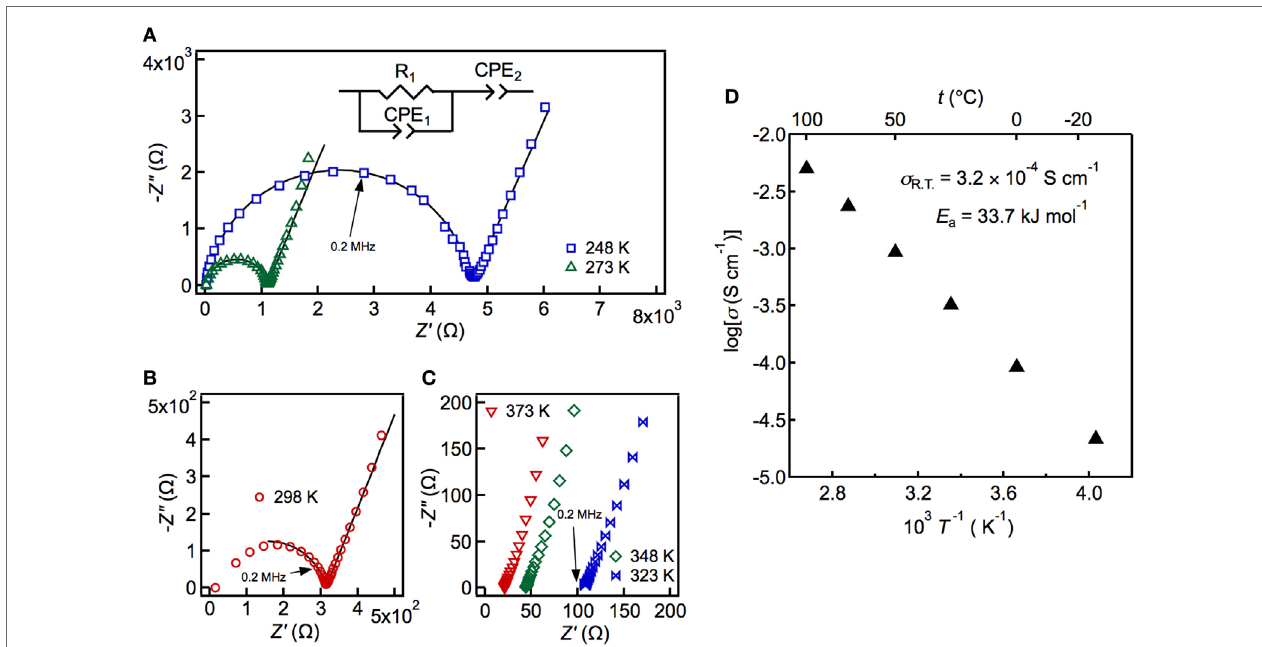
FigUre 3 | impedance plots (a–c) and arrhenius plots of the conductivity data (D) measured at 248–373 K . The solid line in the left panel shows the fit obtained using the equivalent circuit (inset), which was composed of the total resistance and the constant-phase elements (CPEs), which, in turn, represent the combined response of the bulk and the grain boundaries, and the electrode response.